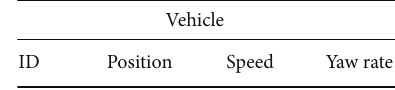
Figure 4: Components of Status Report (SR).